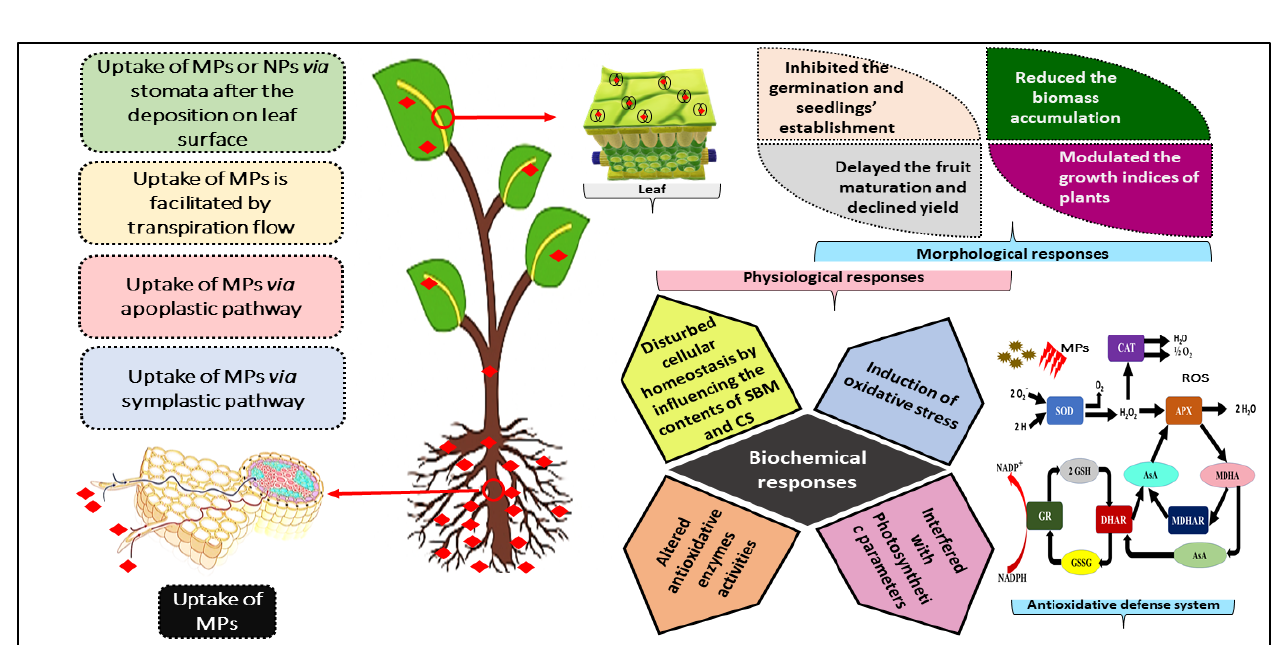
Figure 4. Scheme of microplastic uptake and morpho-physiological implications in plants; SOD: superoxide dismutase, POD: peroxidases, APX: ascorbate peroxidase, MDHA: monodehydroascor- bate, MDHAR: monodehydroascorbate reductase, AsA: ascorbate, GR: glutathione reductase,